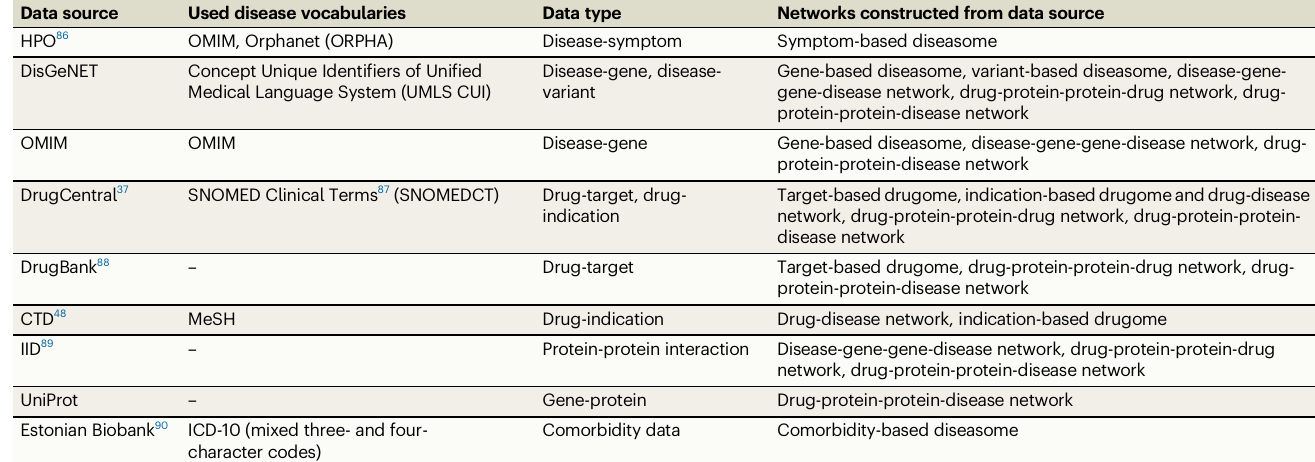
Table 1 | Data sources used for network